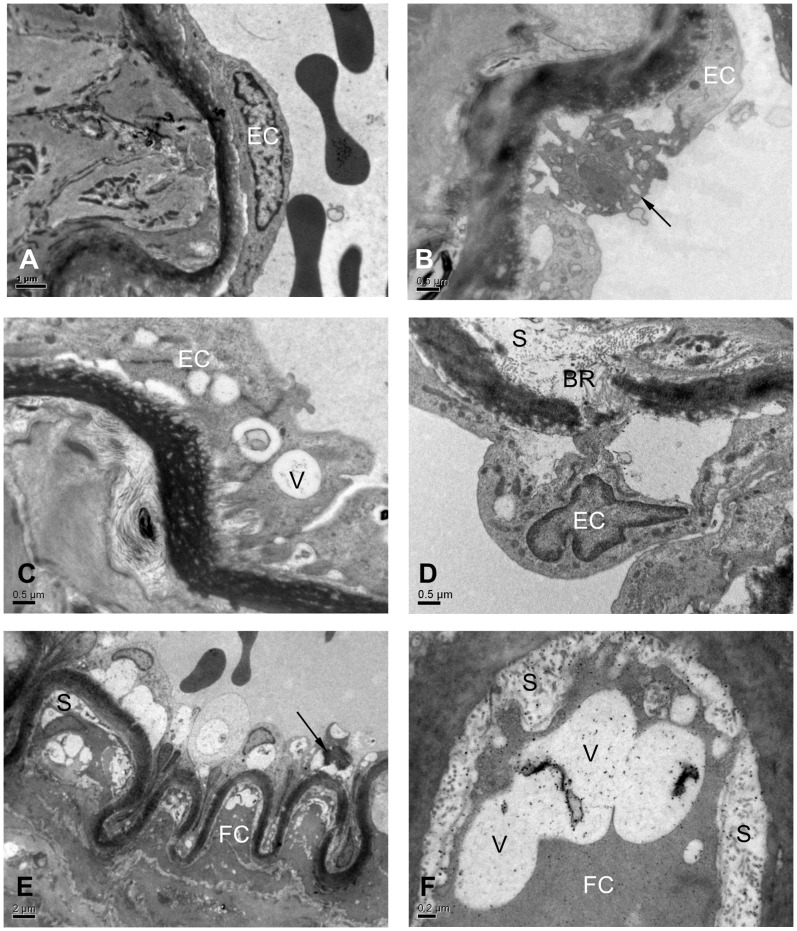
Electron micrographs of the MCA.(A) Sham operated rabbit on a normal diet showing continuous endothelial cells (EC) (B) Hypertension only rabbit, showing a pyknotic cell (arrow) in the endothelial layer (EC). (C) Hypercholesterolemia plus sham rabbit, showing large intracellular vacuoles (V) in endothelial cells. (D) Hypertension plus hypercholesterolemia rabbit, showing breaks in the basement membrane (BR), and a large extracellular space (S) between the basement membrane and the underlying smooth muscle cells. (E) Hypertension plus hypercholesterolemia rabbit, showing a pyknotic cell among the endothelial layer (arrow), and presence subendothelial foam cells (FC). (F) Higher magnification of a foam cell in E, showing intracellular vacuoles, and extracellular spaces (S) containing collagen fibrils. Scale: A = 1 µm, B–D = 0.5 µm, E = 2 µm, F = 0.2 µm.